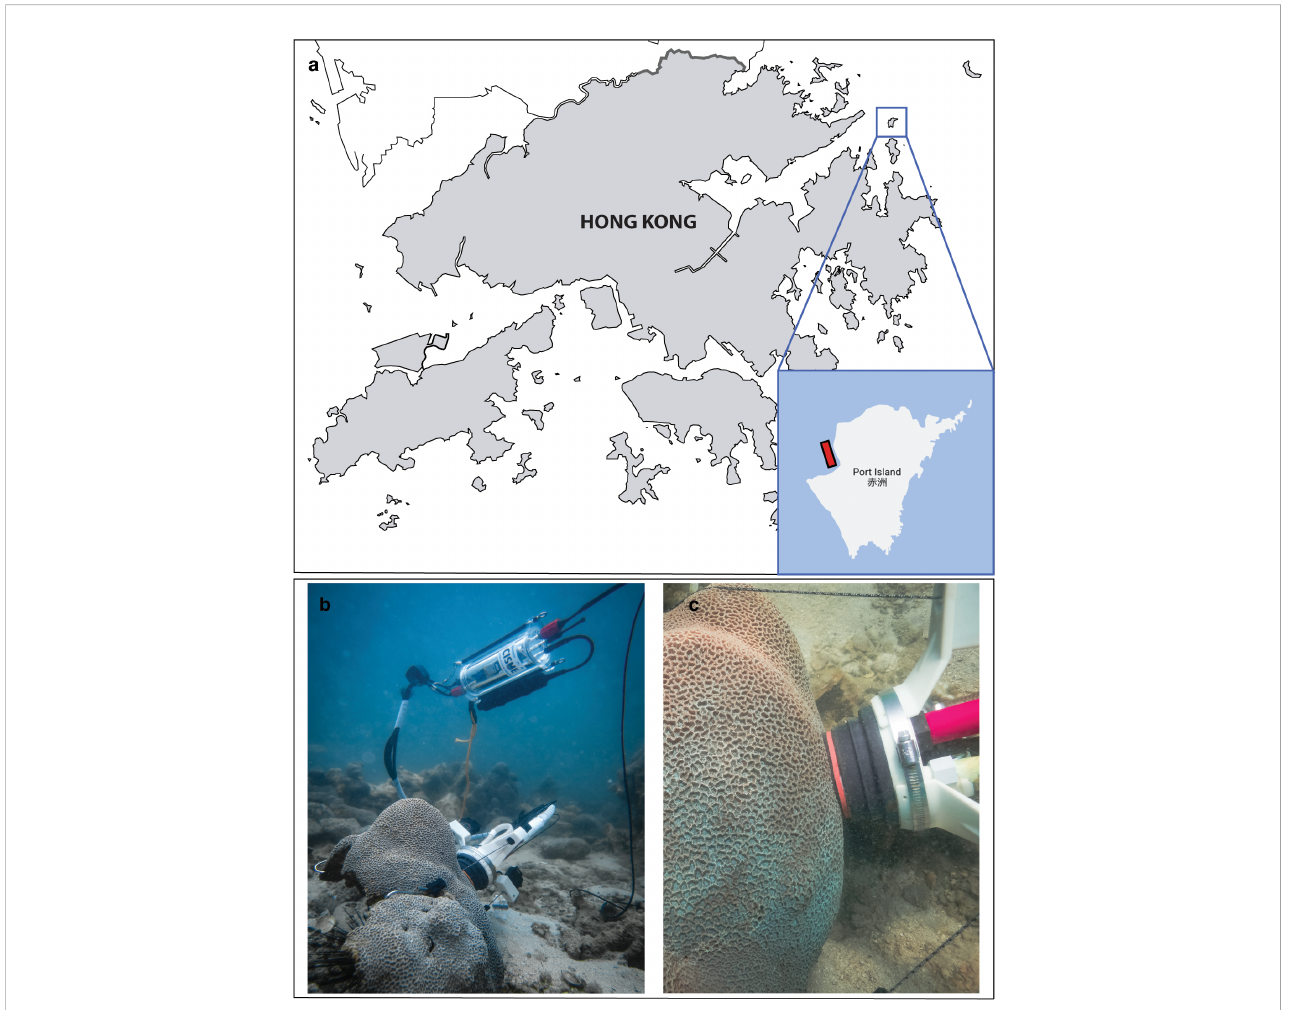
FIGURE 1 Location of the survey site in Mirs Bay, Port Island (Hong Kong). (A) The area where P. carnosa corals were found is highlighted in red; (B, C) show detailed images of the CISME underwater respirometer deployed on P. carnosa